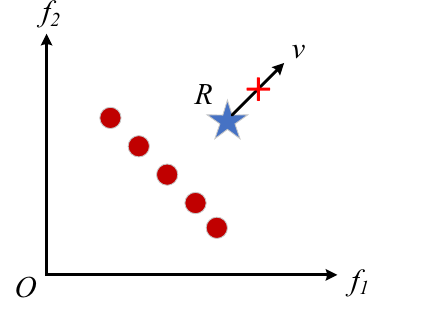
Fig.3 The reference point dominates parts of non-dominated solutions